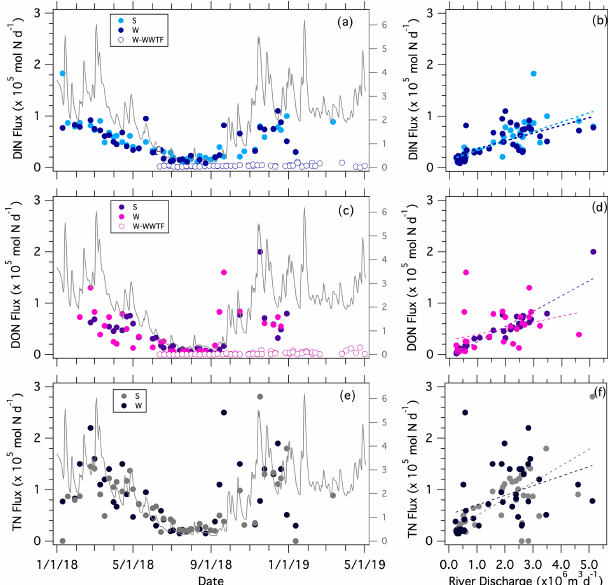
Figure 4. Weekly estimates of N fluxes at the Stillman and Westerly bridges and from the Westerly WWTF vs. sampling date (super- posed onto river discharge) and vs. the mean daily river discharge recorded at the Stillman Bridge. The secondary axis in the left-hand panels is the river discharge ( × 10 6 m 3 d − 1 ). DIN flux vs. (a) sam- pling date and (b) mean daily river discharge; DON flux vs. (c) sam- pling date and (d) mean daily river discharge; TN flux (the sum of DIN, DON, and PN) vs. (e) sampling date and (f) mean daily river discharge. Statistical fits of least-square linear regressions are re- ported in Table